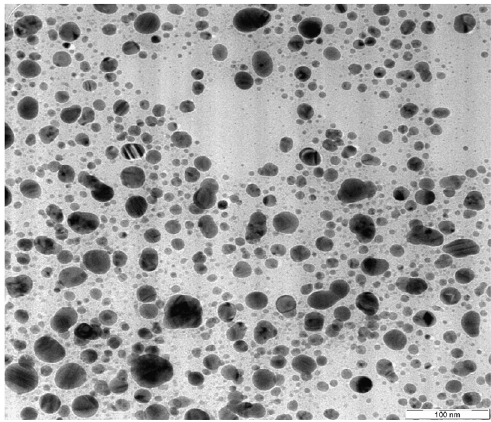
Fig. 3. TEM analysis of synthesized